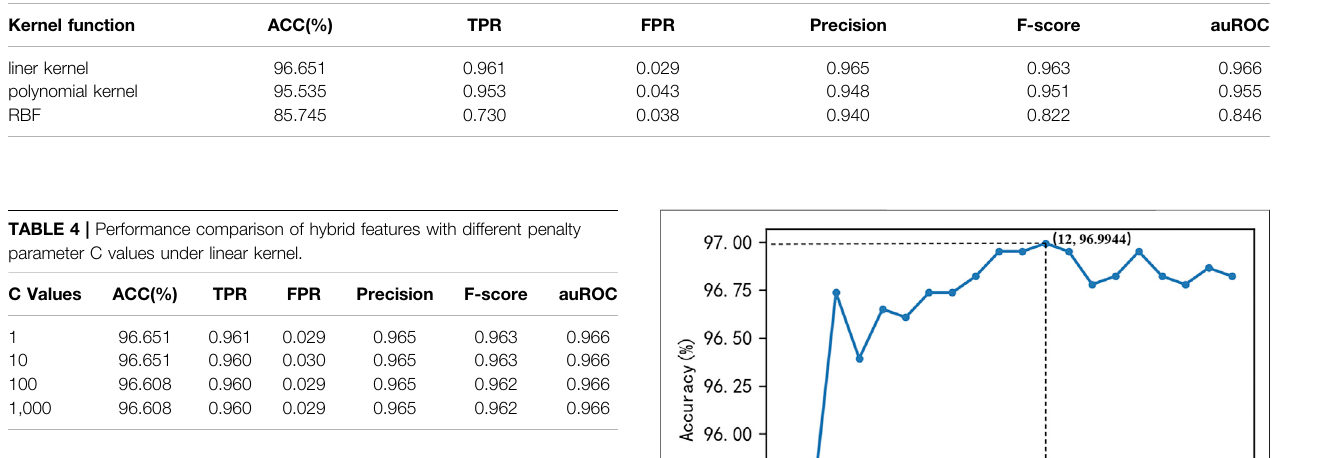
TABLE5| Comparisonofclassi fi cationperformanceofhybridfeaturesbeforeand after using MRMD feature selection. Number of feature